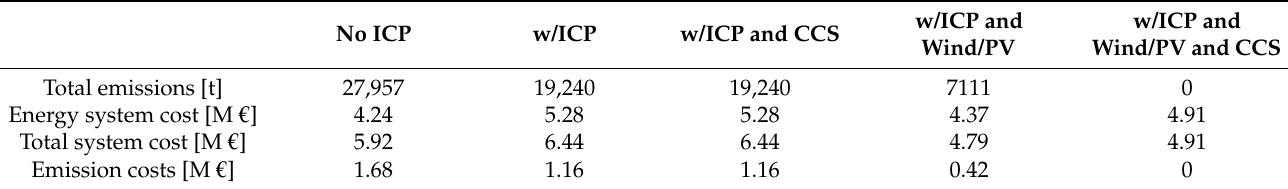
Table 7. Cost and emission overview for the German